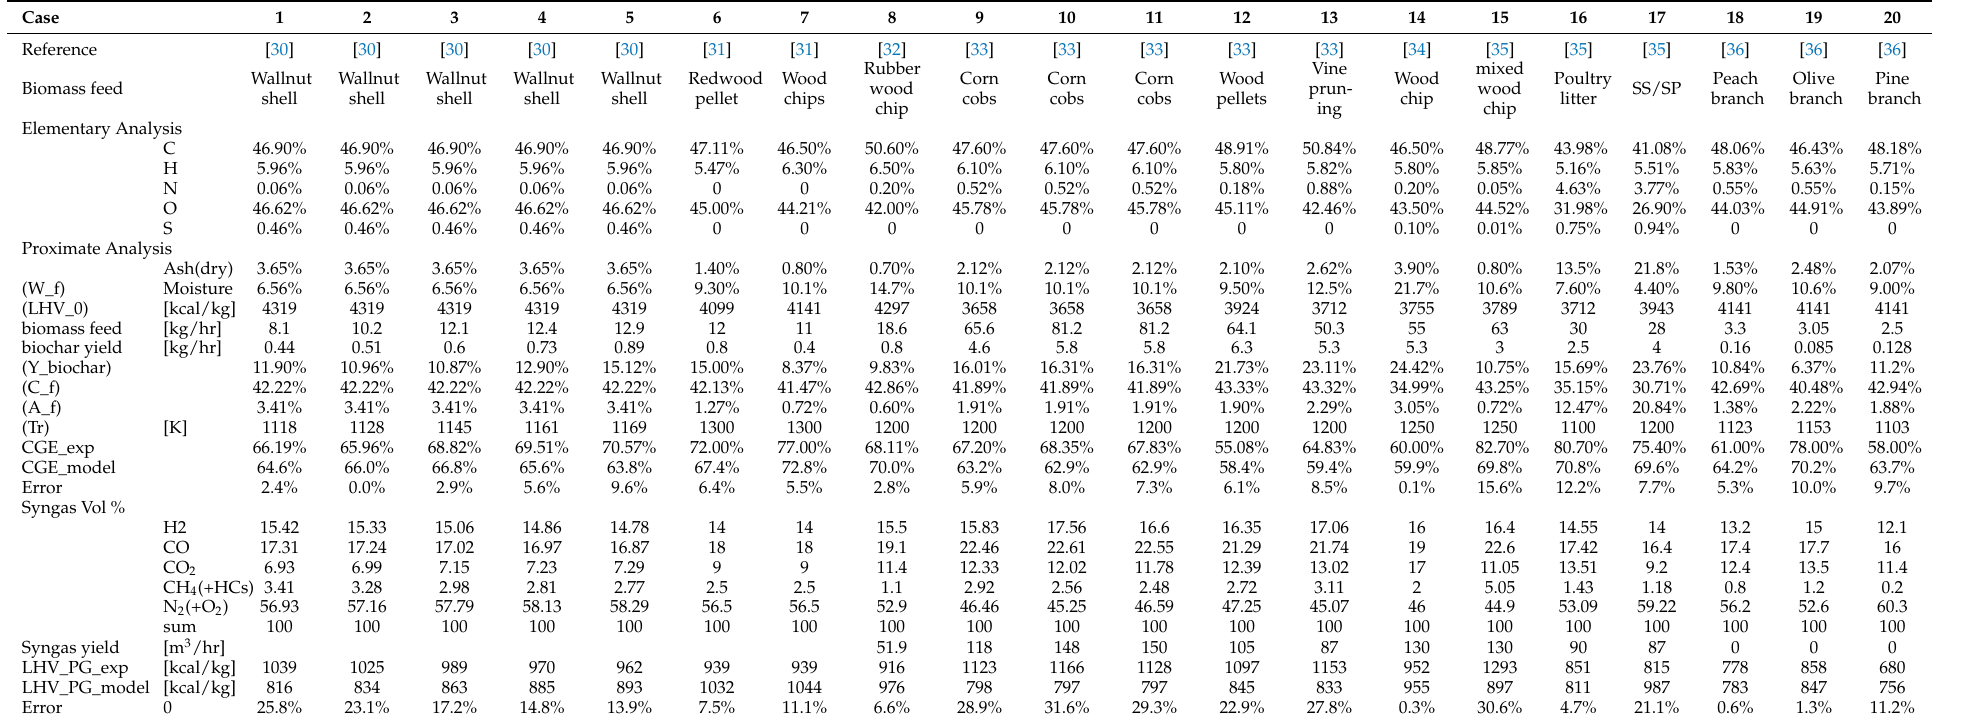
Table 6. Comparison between experimental results and regression model. ( ) parameters of regression